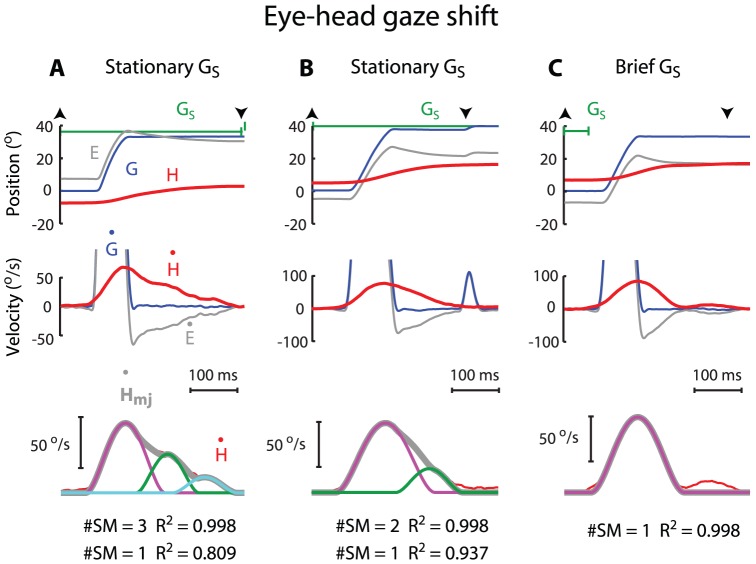
Three examples of submovement composition of head movement during eye-head combined gaze shifts.For stationary gaze target (A–B), task-associated head movement, indicated as arrowheads ▴ and ▾, was included up to the end of gaze target display (A) or the onset of correction saccade when correction gaze shifts occurred (B). For flashed gaze target (C), task-associated head movement was included up to 200 ms following gaze end. Note the goodness of fit in A improved by 18.9% from a single submovement (#SM = 1; 19.1% error) to 3 overlapping submovements (#SM = 3; 0.2% error). The goodness of fit in B improved by 6.1% from a single submovement (#SM = 1; 6.3% error) to 2 overlapping submovements (#SM = 2; 0.2% error). Same format as in Fig. 2.